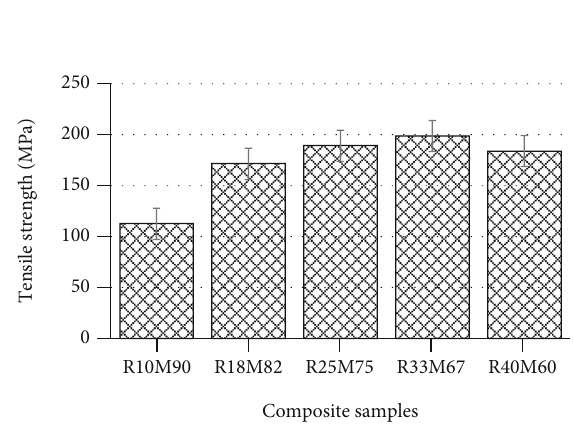
Figure 3: Tensile